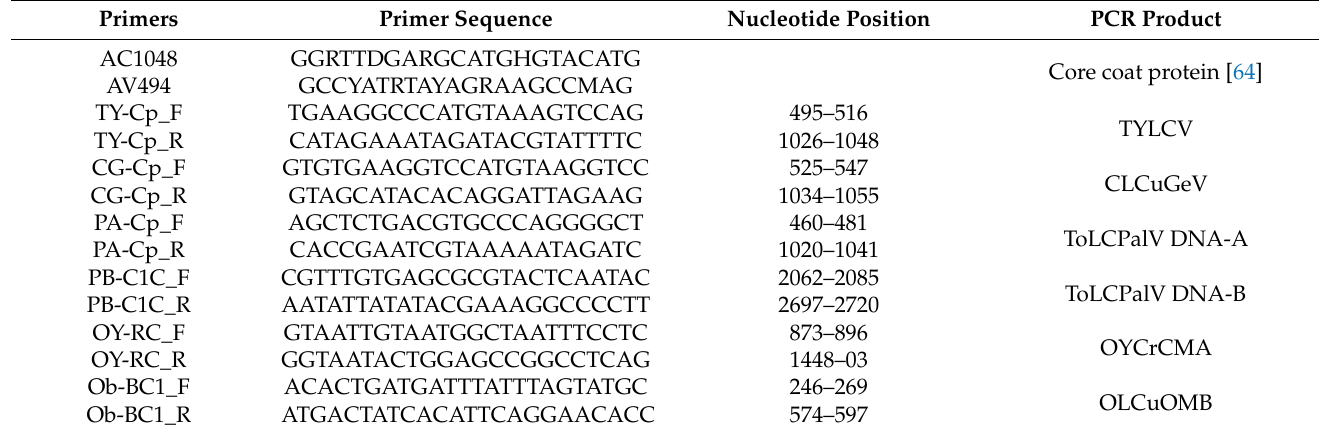
Table 3. Oligonucleotide sequences used in this